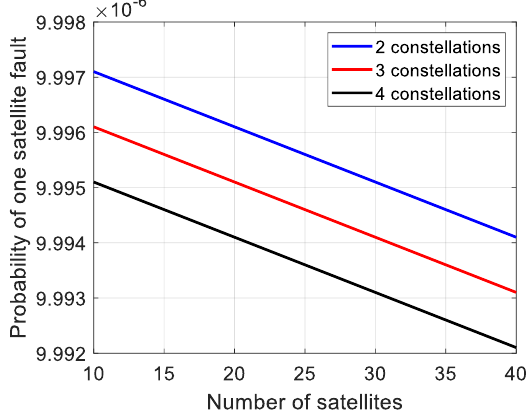
Figure 1. Probability of one satellite fault.